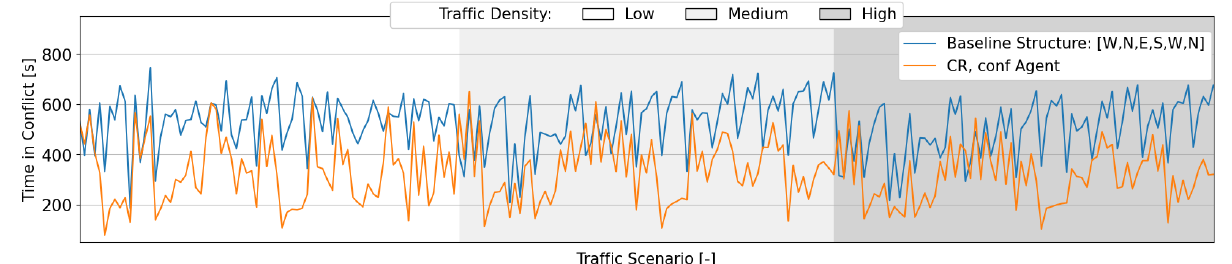
Figure 15. Total time in conflict per aircraft. All traffic densities had 75 traffic scenarios, with the initial direction(s) and the number of turns following the same order as shown during the training